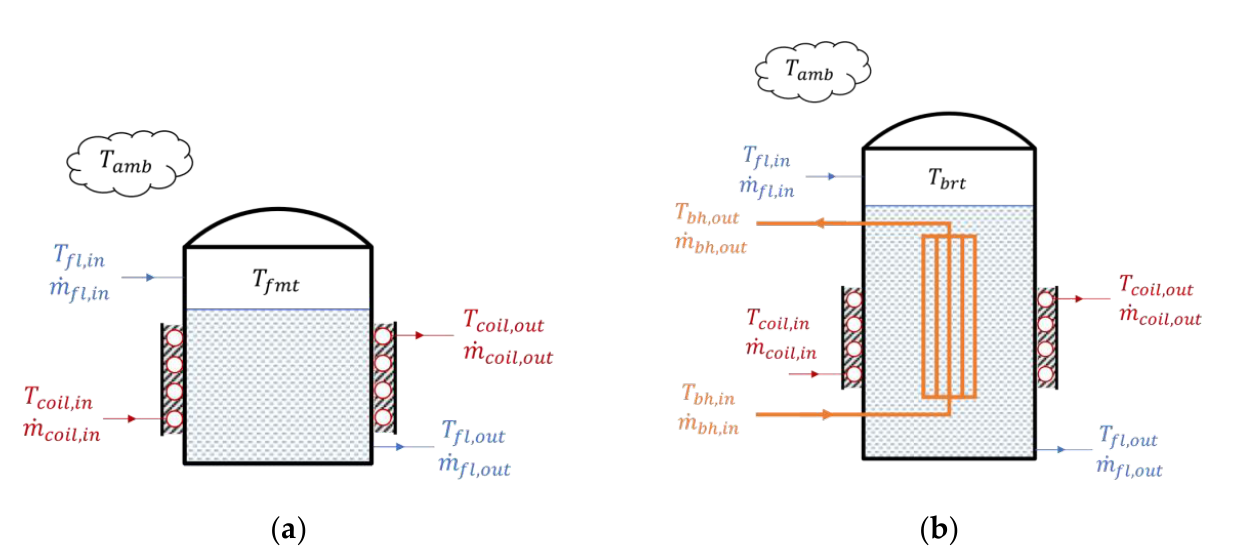
Figure 8. Heat and mass interaction for the ( a ) feed-mixing tank and ( b ) bioreactor tank in the integrated gasification combined cycle biohydrogen production system. The developed dynamic equations for determining the temperatures of the feed- mixing tank and the bioreactor tank in the bio-IGCC model are expressed in Equations (9) and (10),